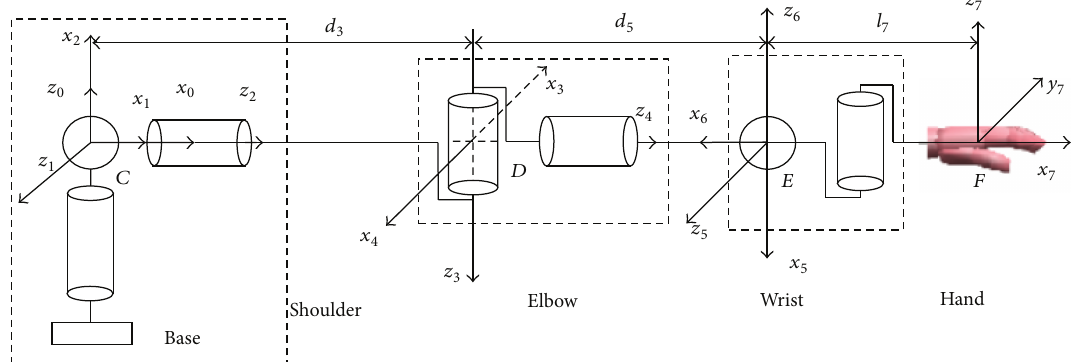
Figure 3: Human arm model and its primary D-H coordinate system and the initial position of each joint angle.